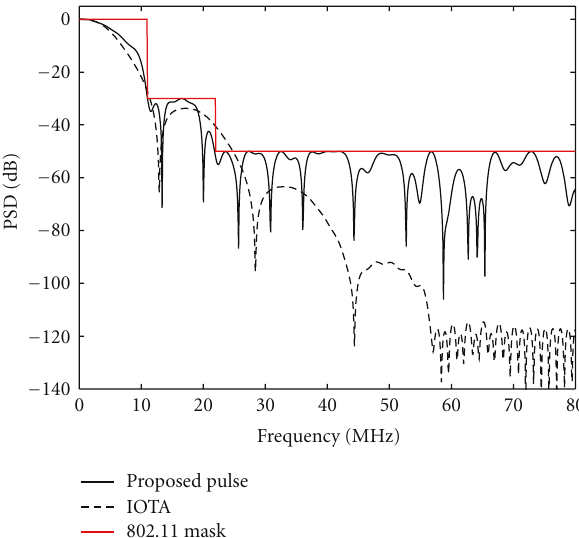
Figure 3: Pulse-shapes in the frequency domain for symbol rate 10M/sec.